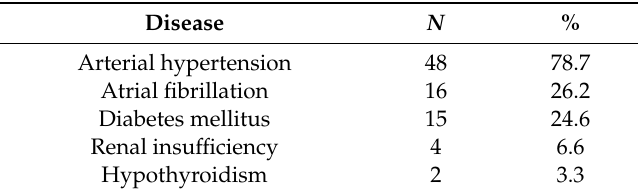
Table 2. Comorbidity